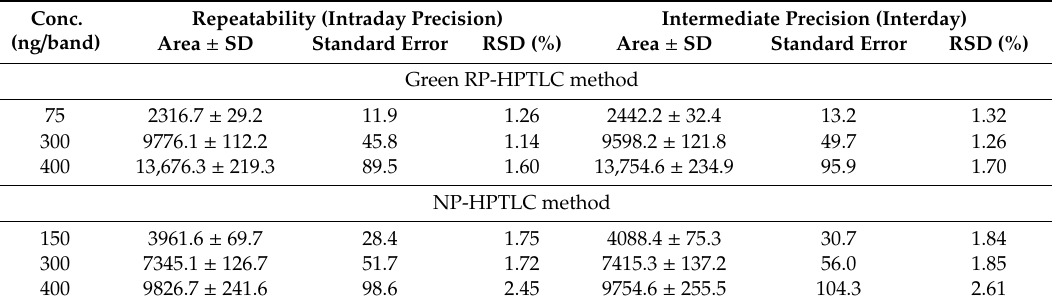
Table 4. Precision data for the green RP-HPTLC and NP-HPTLC methods ( n = 6). Conc. (ng / band)